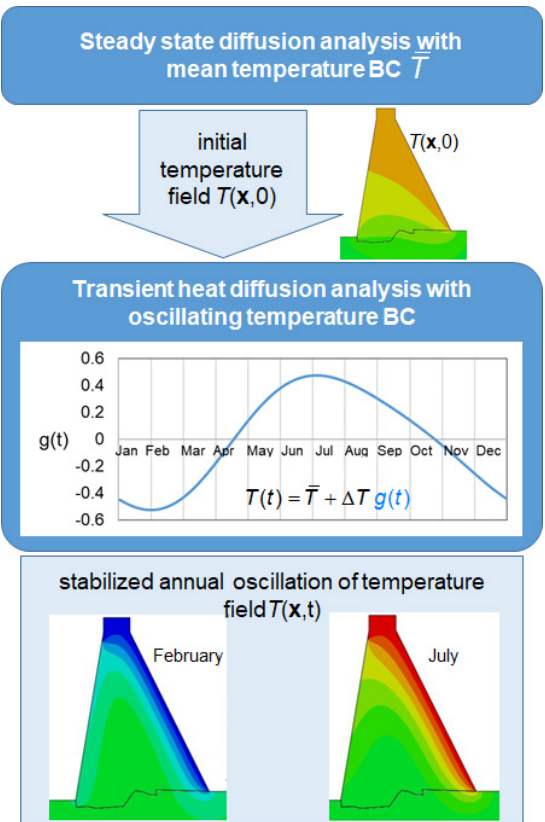
Figure 10. Flowchart of the heat diffusion analyses to determine the yearly evolution of the temperature field.